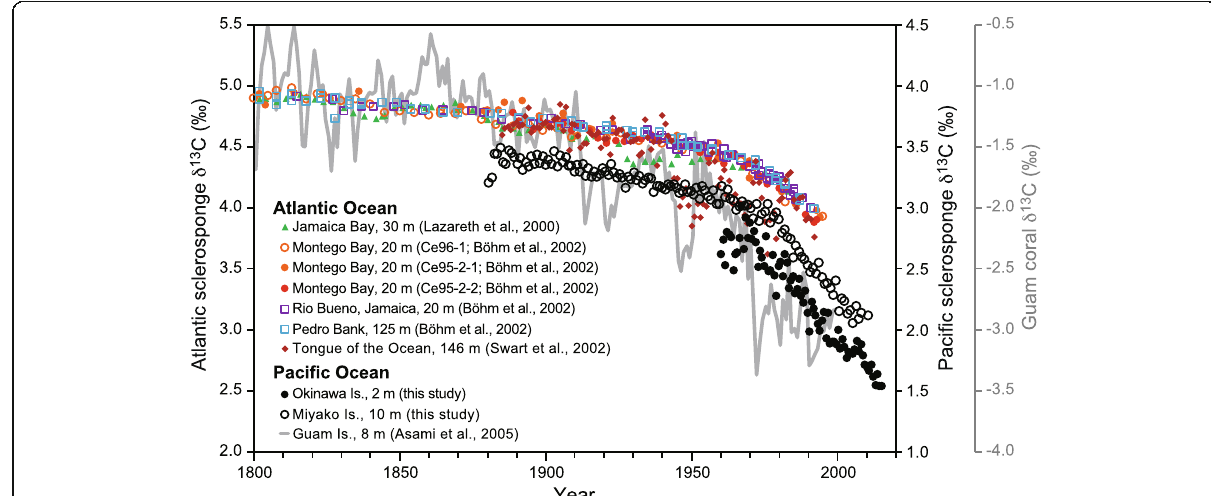
Fig. 6 Time series of sclerosponge δ 13 C from Miyako and Okinawa Islands in the northwestern subtropical Pacific compared to earlier published data from sclerosponges in the tropical Atlantic (Lazareth et al. 2000; Böhm et al. 2002; Swart et al. 2002) and a Porites sp. coral in the western tropical Pacific (Asami et al.